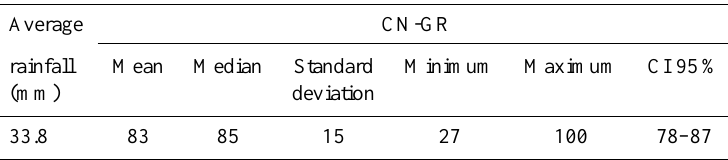
Table 1. CN GR values estimated and statistics.